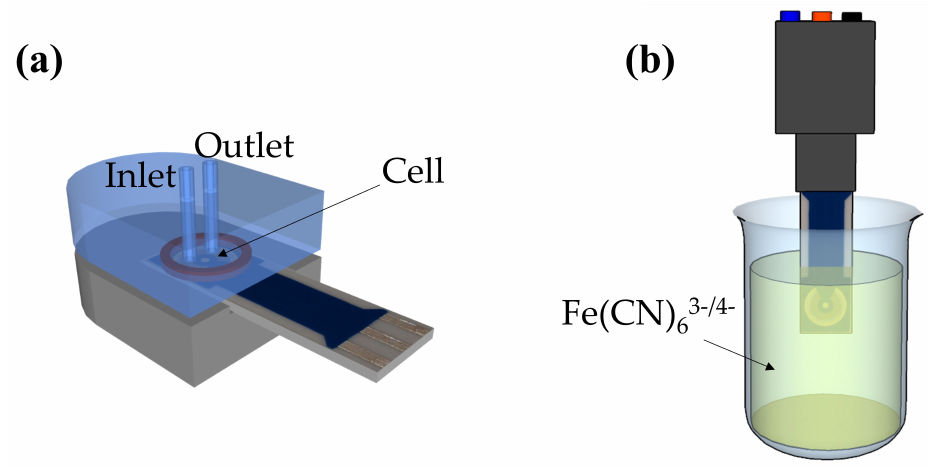
Figure 1. ( a ) Sketch of the fluidic cell used for an e ff ective interaction of the solutions (Abs, BSA and E. coli ) with the electrode and ( b ) scheme used for the electrochemical measurements: the AuSPE was dipped in a beaker containing 1.5 mL of Fe(CN) 63 − / 4 − and it was connected to the potentiostat through a holder (in grey) for the impedance / current